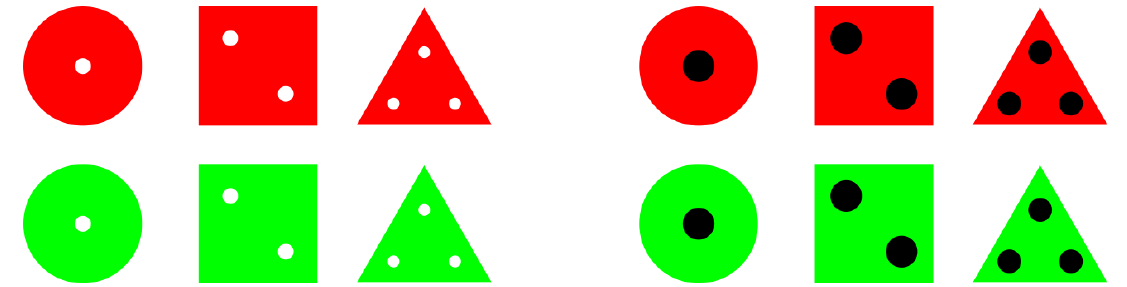
Figure 3. Design of the manufactured parts and the covers for the use